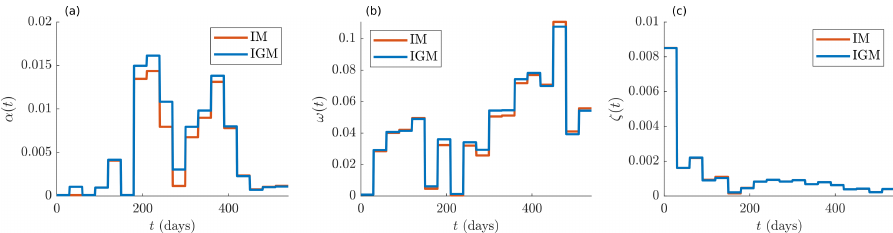
Figure 5. Estimation results of the time-varying parameters α (subplot ( a )), ω (subplot ( b )) and ζ (subplot ( c )). The piecewise shape of the curves is due to the fact that these parameters are constant over each time window of T w = 30